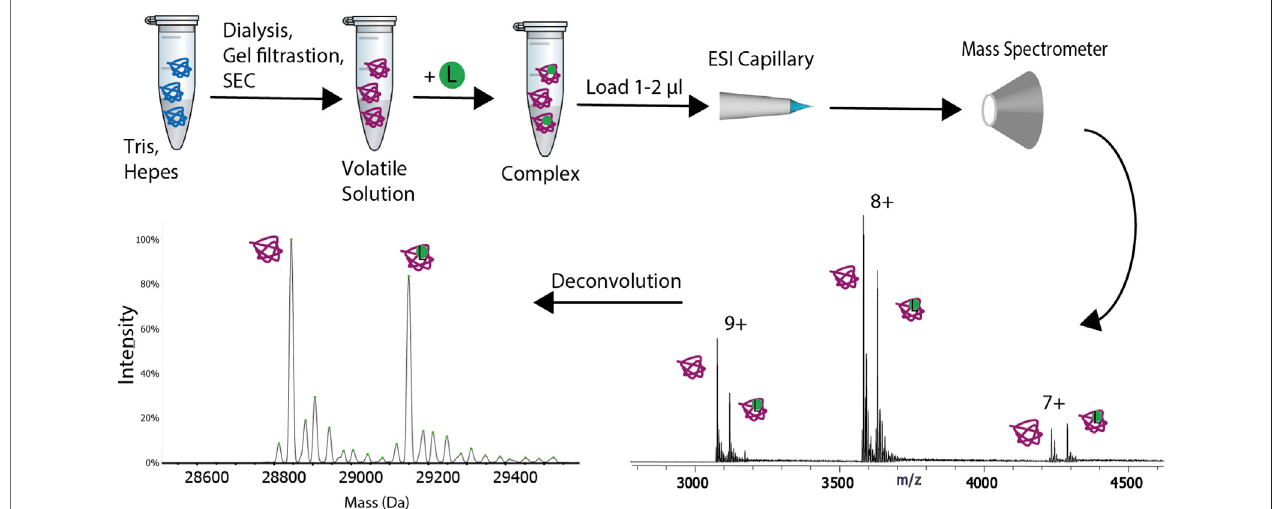
FIGURE 1 | Schematic representation of the experimental procedure for native mass spectrometry. The sample is transferred from its buffer to a volatile solution. Bufferexchangecanbeperformed via oneofthefollowingmethods: gel fi ltration,sizeexclusionchromatography(SEC)ordialysis.ThesampleisthenloadedonaESIor nanoESIcapillaryanditistransferredtothegas-phase.Theionsaresubsequentlyanalyzedwiththemassspectrometer.Aligand(L),representedwithagreencirclecan be added to the buffer exchanged sample. The deconvolution of the spectra will result in two peaks, one for the apo protein and the other for the complex.